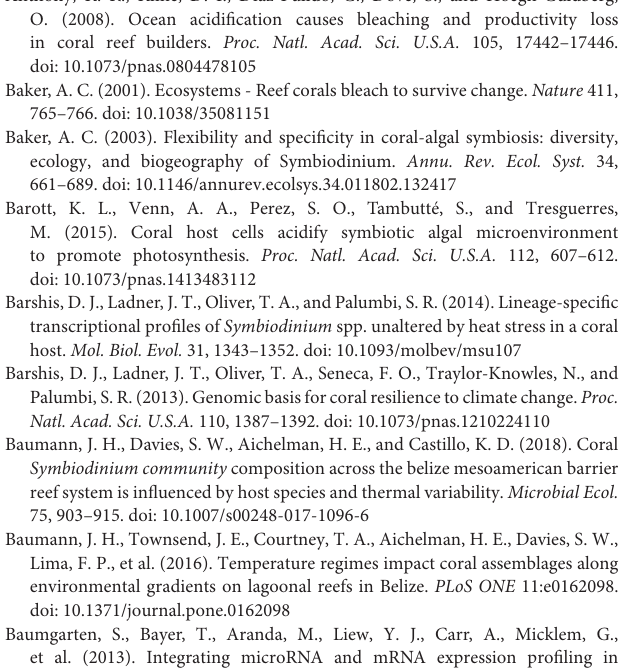
Supplementary Table 3 | Raw Counts Highly Conserved Gene Set for Coral and Symbiont. Supplementary Table 4 | Symbiont normalized counts and gene expression results from DESeq2. Supplementary Table 5 | Genes associated with photosynthetic GO categories in